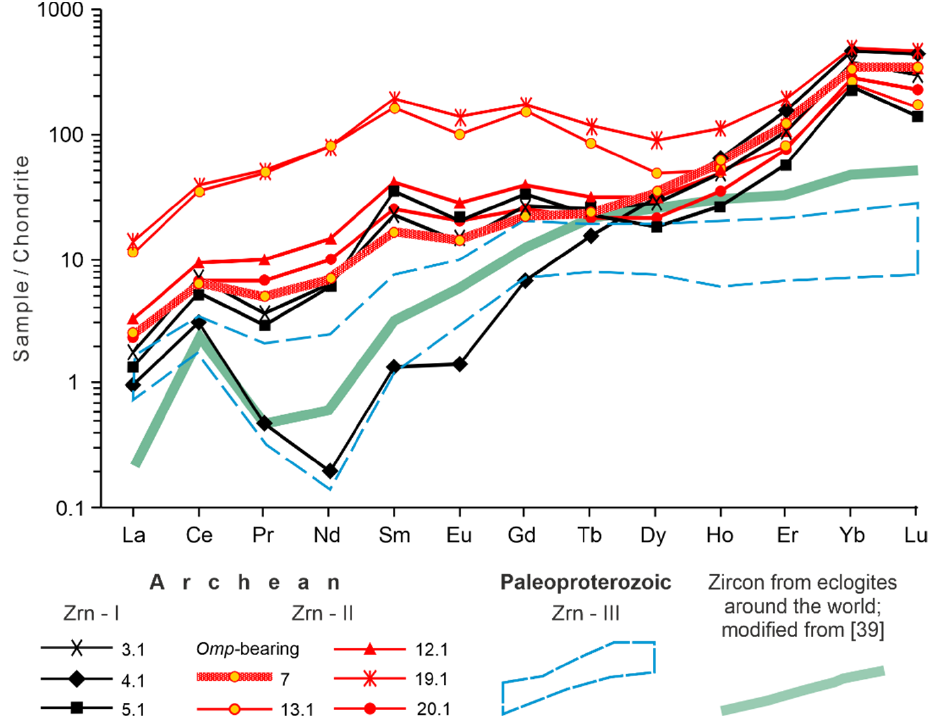
Figure 6. Chondrite-normalized [82] REE concentrations in zircons from eclogite ST-2D eclogites against those in zircons from eclogites from orogenic belts around the world [38]. Table 2. Trace element concentrations (ppm) and element ratios in and crystallization tempera- tures of zircons from massive eclogite S Т -2D.